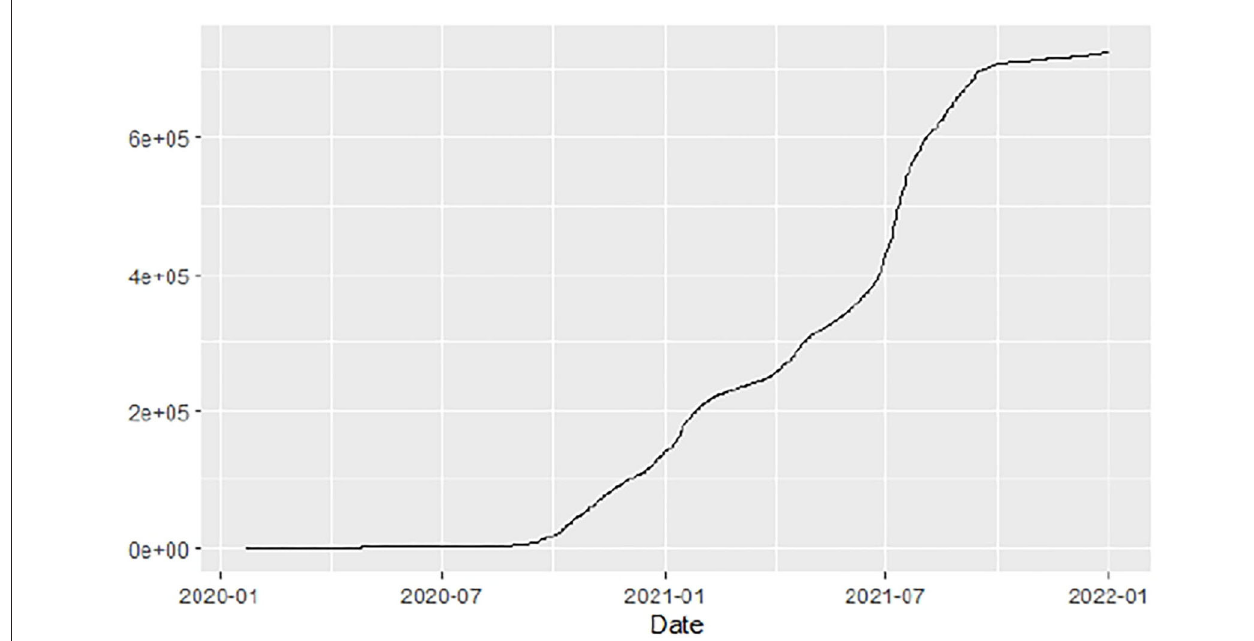
FIGURE 9 | Tunisia cases.